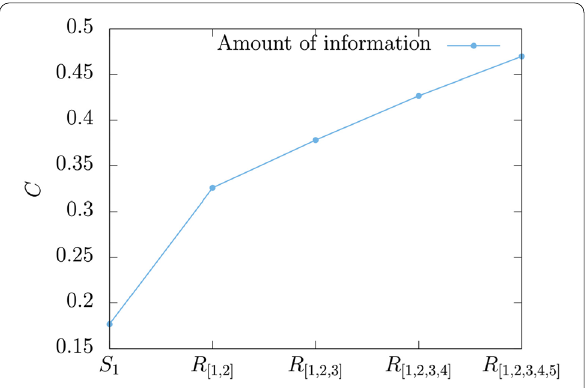
Fig. 10 Example of the stable reconstruction process of our